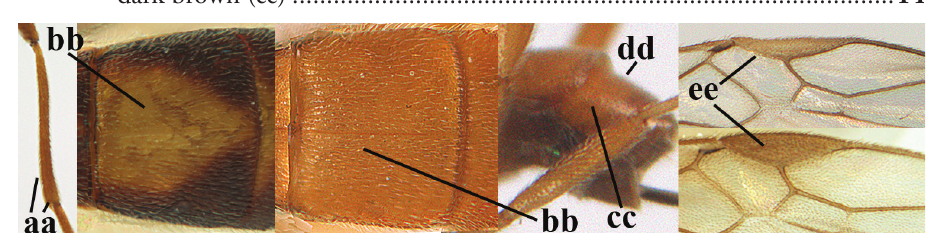
– Antennal segments of ♀ 34–40; hind tibia subapically and apically similarly coloured and brownish yellow (aa); second tergite comparatively short (bb); fourth tergite partly without distinct sharp lateral crease (cc), partly retracted and tergite largely smooth (dd); pterostigma unicoloured yellowish brown or dark brown (ee) ........................................................................................ 14